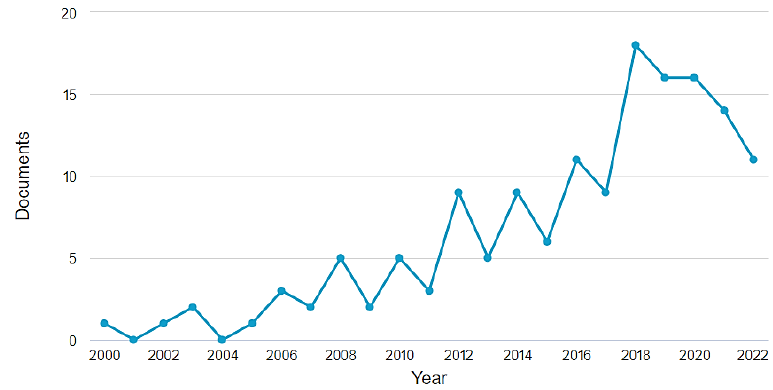
Figure 2. Number of publications per year according to Scopus search results .